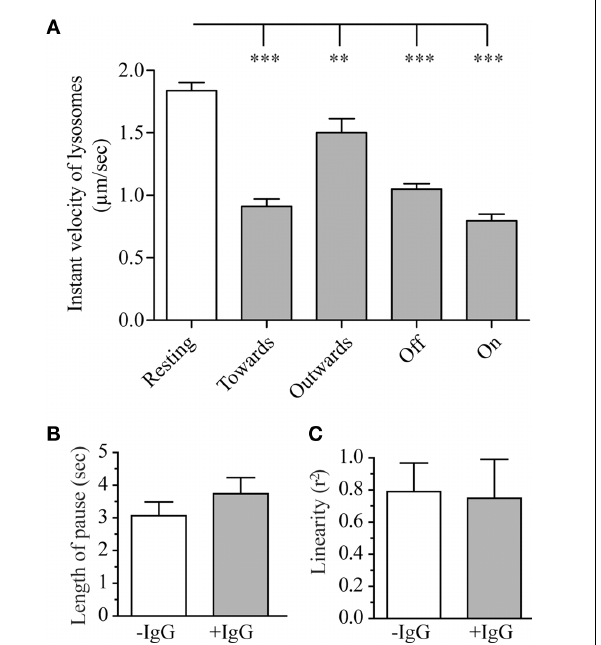
FIGURE 6 | Parameters of the lysosomal movement during frustrated phagocytosis and roles of Src kinases. RAW–GFP expressing cathepsin-D-mCherry were layered on glass cover slips that were micro-patterned with OVA alone ( − IgG, “Resting”) or OVA + anti-OVA antibodies ( + IgG).Tracking of lysosomes was carried out as described in the Section “Materials and Methods.” (A) Instant velocity of lysosomes as a function of their direction relative to the position of frustrated phagosomes (see text for details). (B) Length of the pauses of lysosomes during their saltatory movements. (C) Linearity of the trajectories for lysosomes moving toward a frustrated phagosome. For all graphs, 15–30 lysosomes were measured on three to six different cells per conditions; mean ±